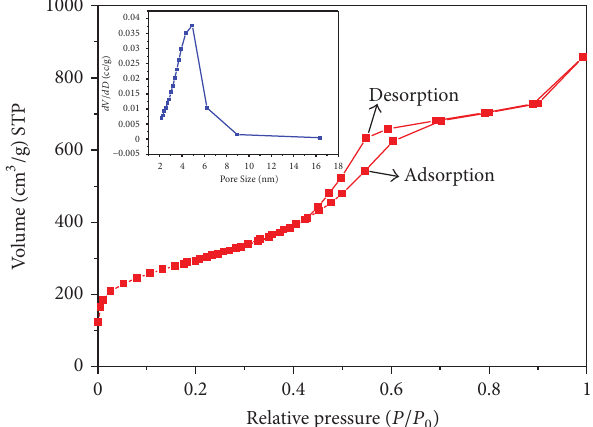
F 4: Nitrogen adsorption-desorption isotherm of magnetic mesoporous FePt/C composites and the corresponding pore size distribution calculated from the desorption branche.